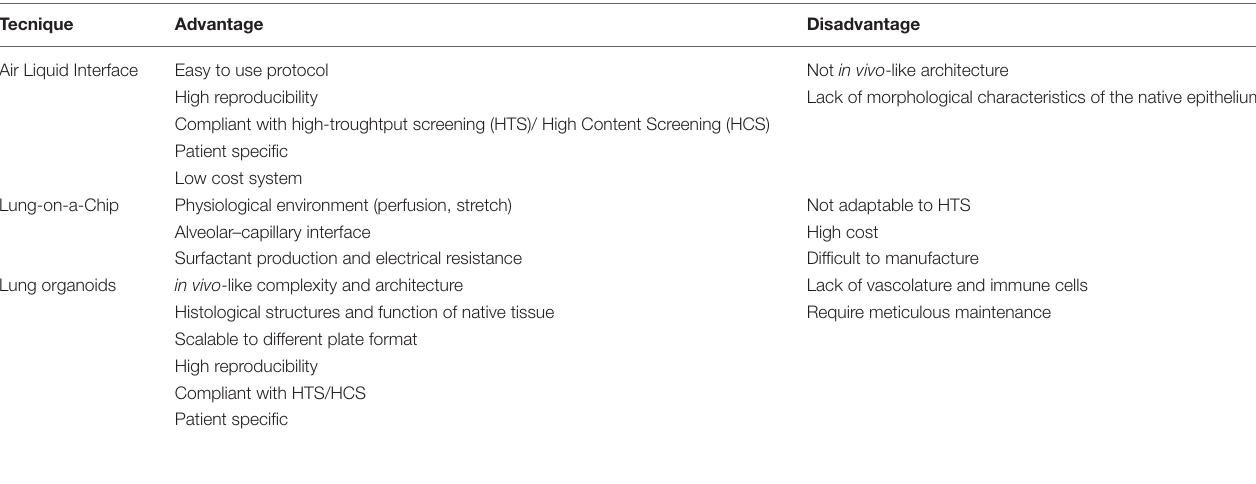
TABLE 1 | Comparison between advanced cell culture techniques for lung infection studies. Tecnique